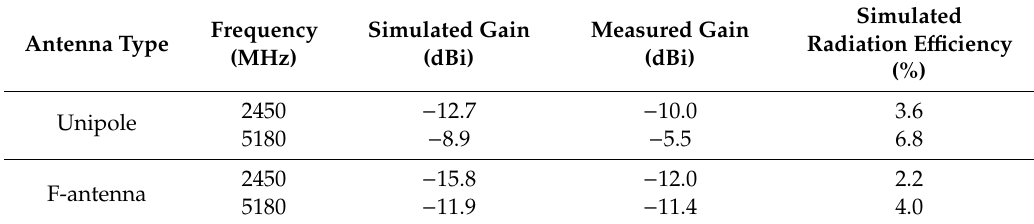
Table 2. Simulated and measured gain of dipole and F-antenna.